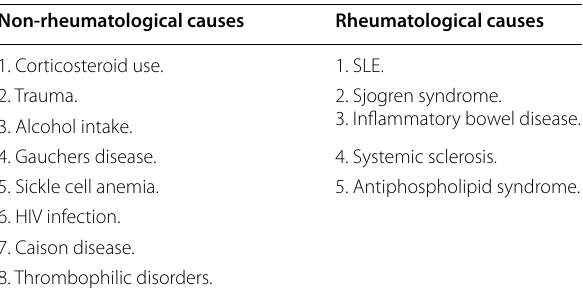
Table 2 Causes of osteonecrosis [1] Non-rheumatological causes Rheumatological